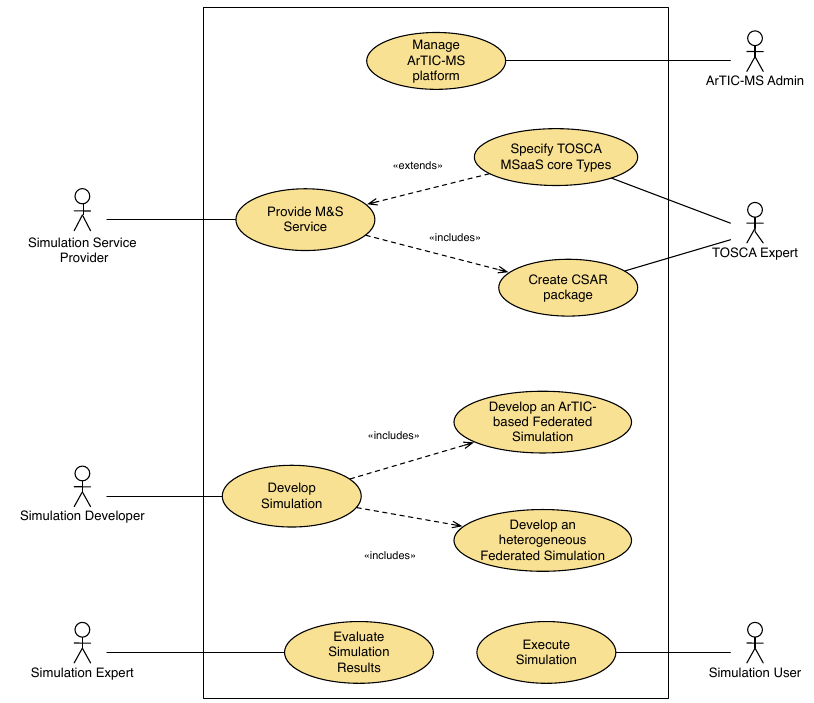
Figure 9. ArTIC-MS use case